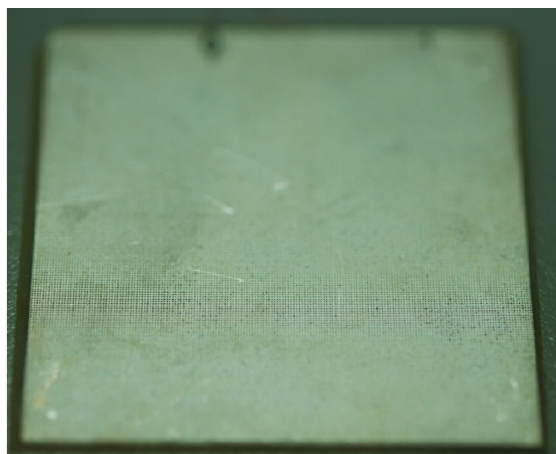
Figure 5. Fabricated pyroelectric